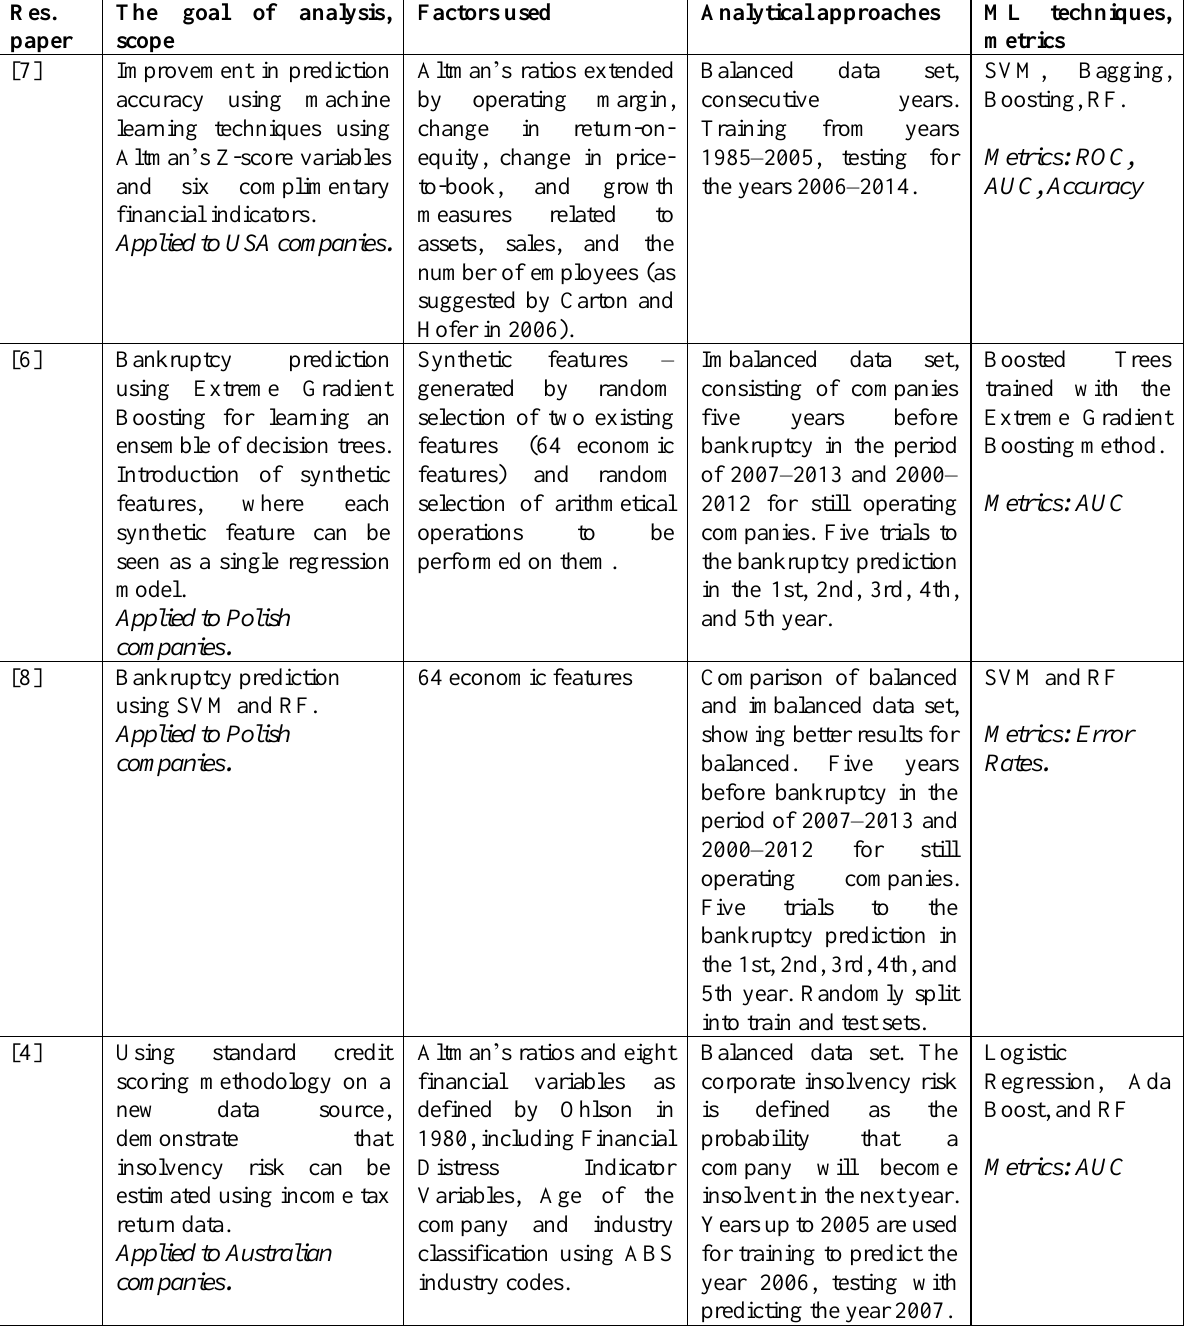
Table 1. Literature analysis on bankruptcy